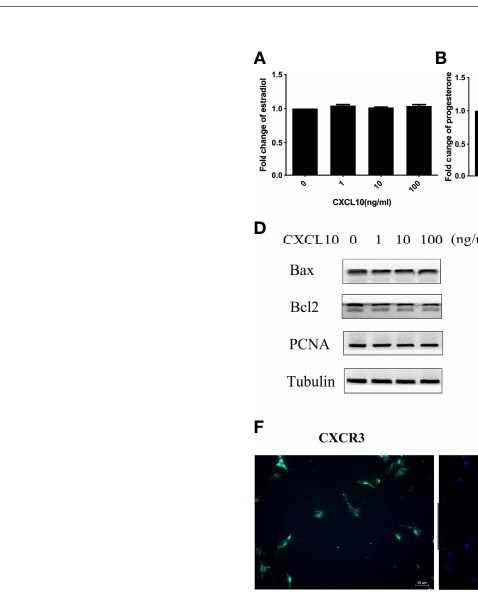
FIGURE 4 | CXCL10 had no effect on human luteinized granulosa (hGL) cells. (A – E) The hGL cells were treated with vehicle control (0) and CXCL10 (1, 10, and 100 ng/ml) for 24 h n = 3. (A) Estradiol levels in culture medium. (B) Progesterone levels in culture medium. (C) Cell viability of hGL cells. (D) Representative Western blot of Bcl2, Bax, and PCNA in hGL cells. (E) Quantitative analysis of Bcl2, Bax, and PCNA protein levels. (F) Immuno fl uorescence staining of CXCR3 (green) in granulosa cells.